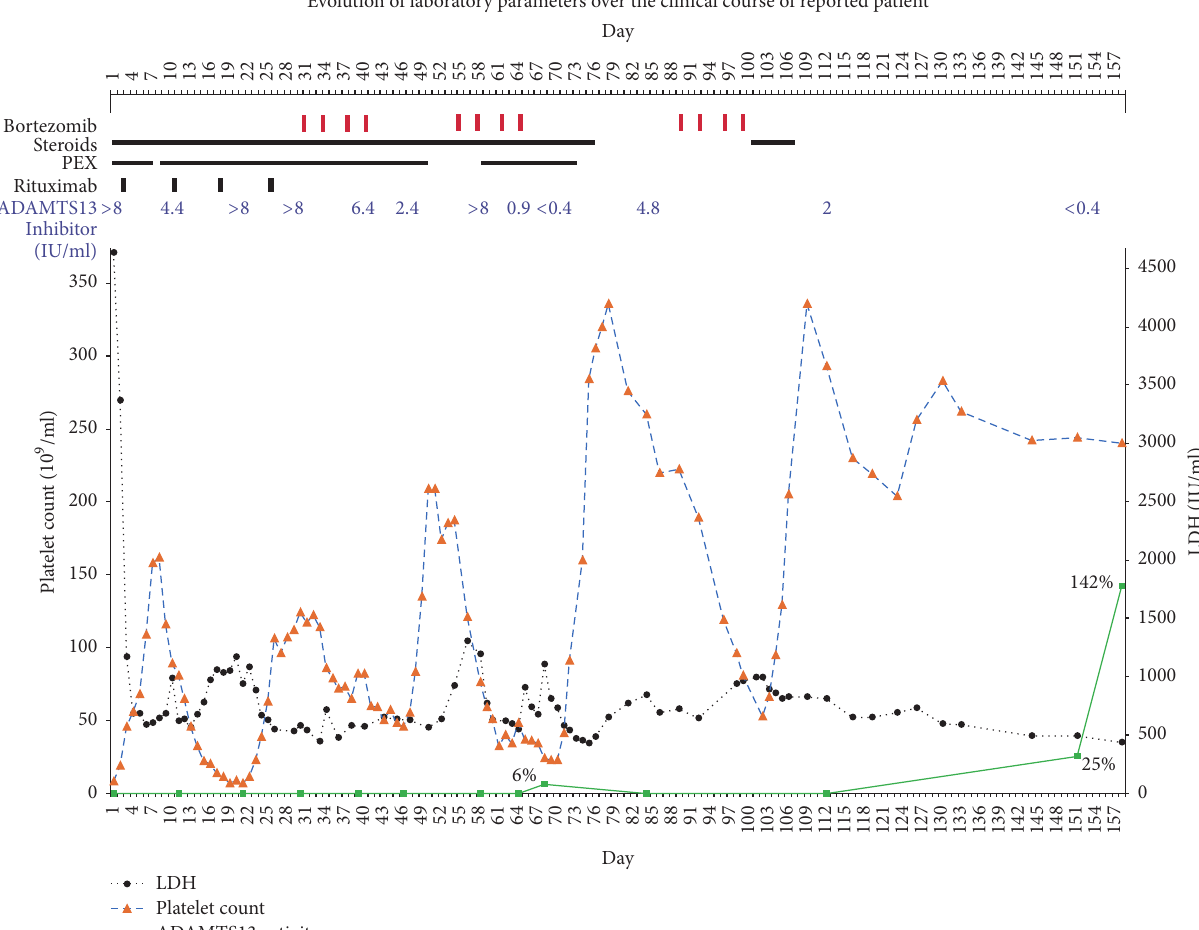
Figure 1: Evolution of laboratory parameters demonstrating patient’s clinical course during the relapsed TTP episode. Major therapies delivered have been indicated. LDH: lactate dehydrogenase; PEX: plasma